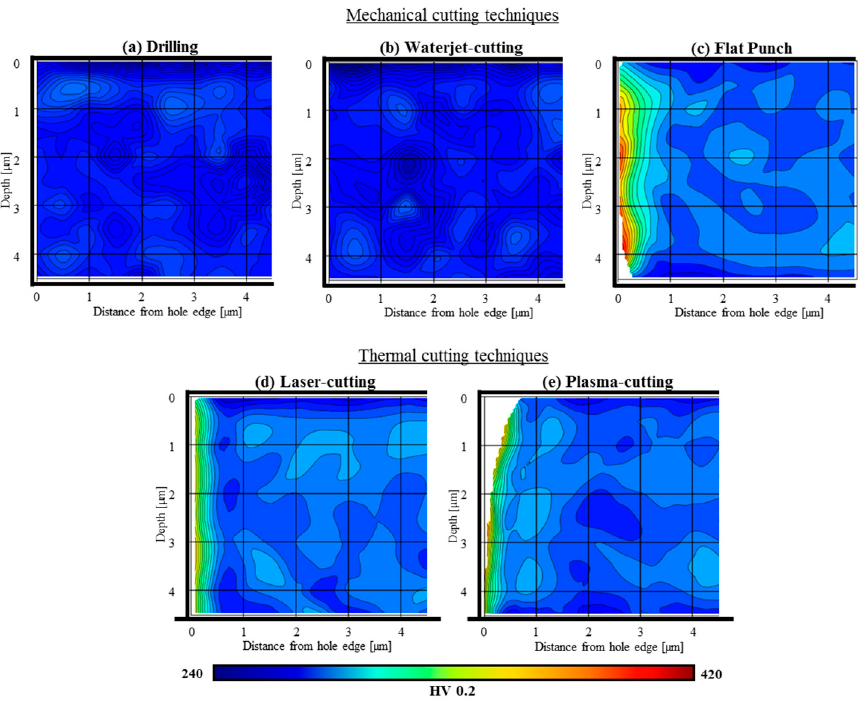
Figure 10. Hardness distribution near the hole edge in HSLA grade S700MC for various hole-making procedures: ( a ) drilling, ( b ) waterjet-cutting, ( c ) flat punching, ( d ) laser-cutting and ( e ) plasma-cutting. The hole edge is located on the left side of the images.